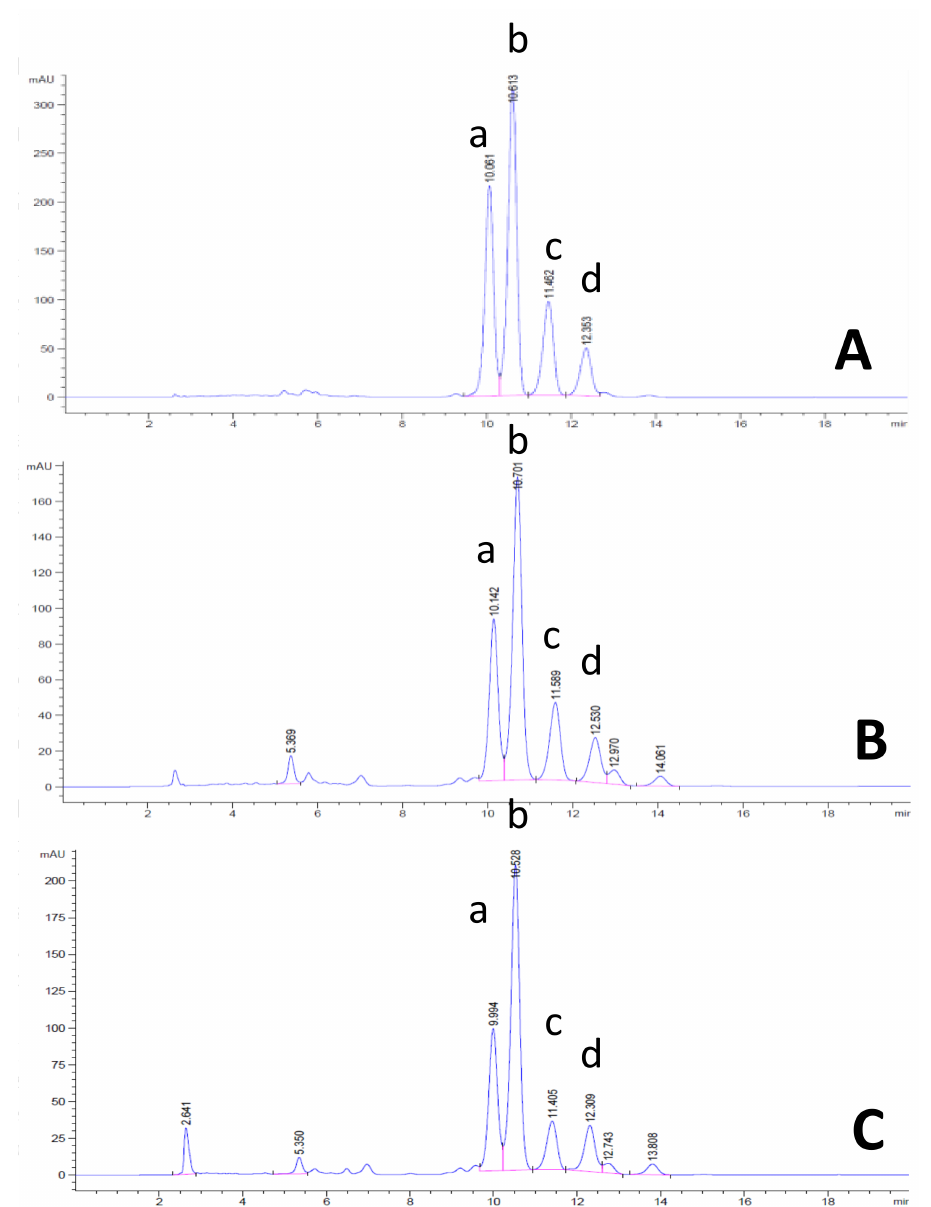
Figure 2. HPLC chromatogram of reference γ -oryzanol and NPRBOs. ( A ) γ -oryzanol, which is composed of cycloartenyl ferulate(a), 24-methylenecycloartanyl ferulate (b), campesteryl ferulate (c), and sitosteryl ferulate (d); and NPRBOs, including ( B ) Khao’ Gam Leum-Phua and ( C ) Khao’ Gam Pah